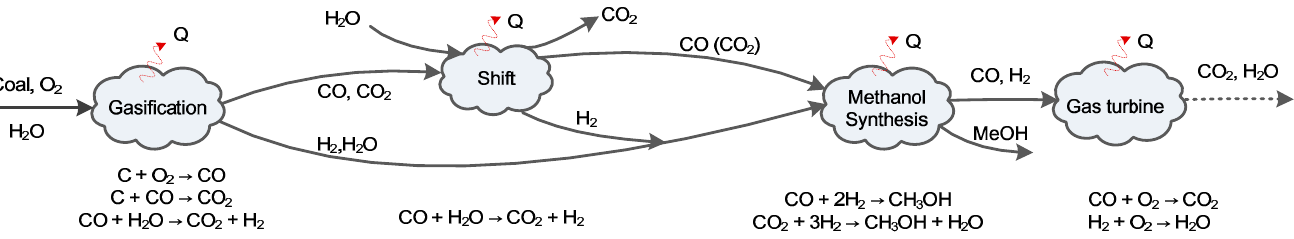
Figure 2. Energy and material conversion in a coal-based polygeneration system.